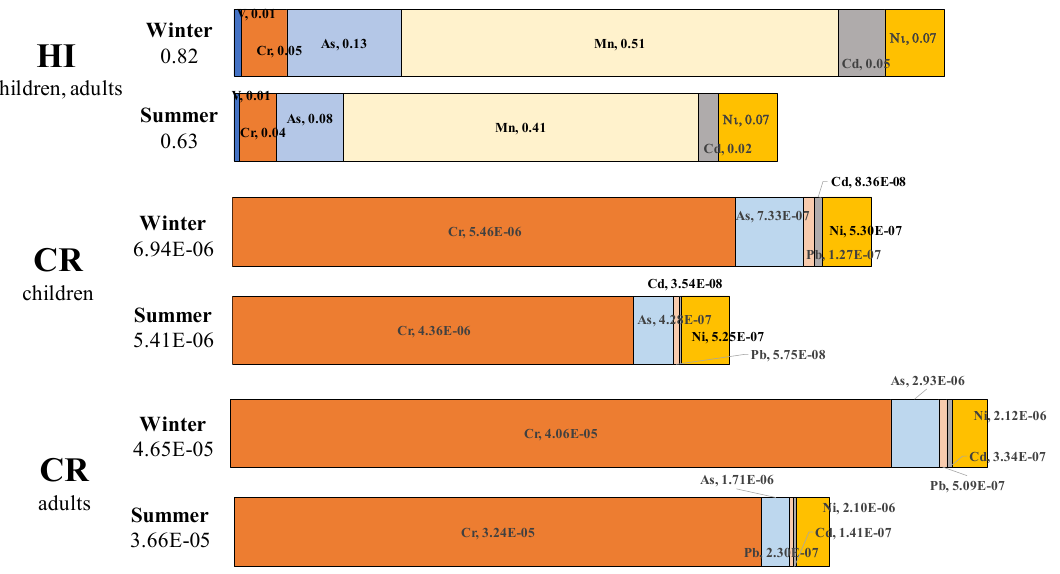
Figure 6. Hazard index (HI) and carcinogenic risk (CR) values for children and adults during winter and summer sampling periods.